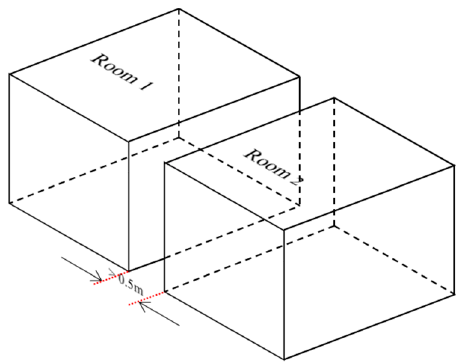
Figure 3. Adjacent rooms, assigned numbers 1 and 2, in order of detection in the processing.